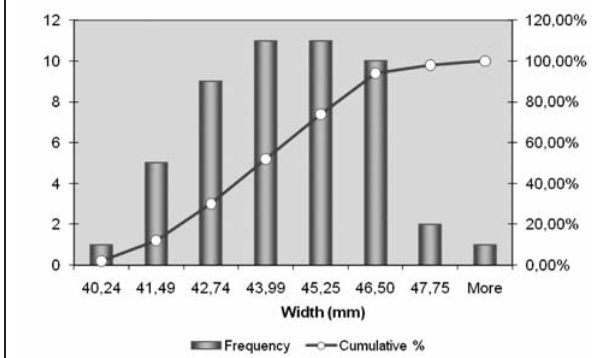
Fig. 20: Distribution of the width values of category B of Jumbo Cot Fig. 21 : Distribution of the width values of category A of Jumbo Cot